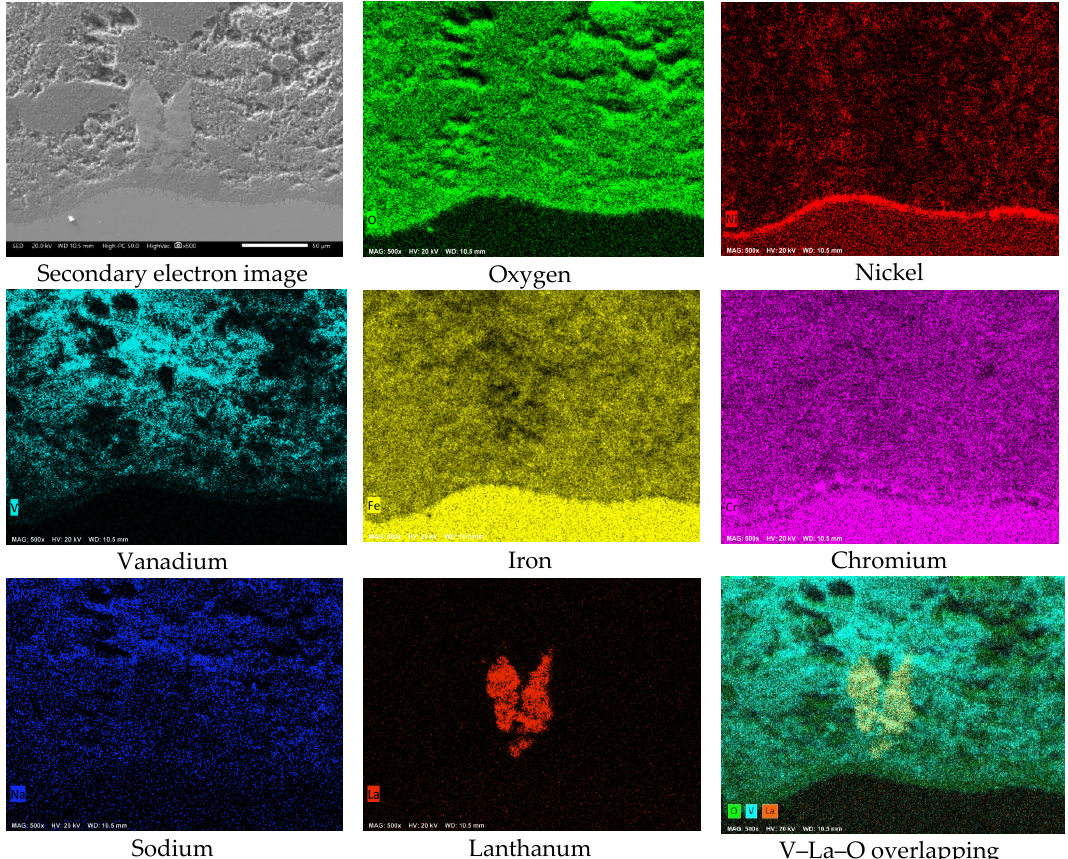
Figure 10. Cross-sectional aspect and element mapping of the 304H steel interface corroded in NaVO 3 with 10% La(Ac) 3 at 900 °C after 100 h.